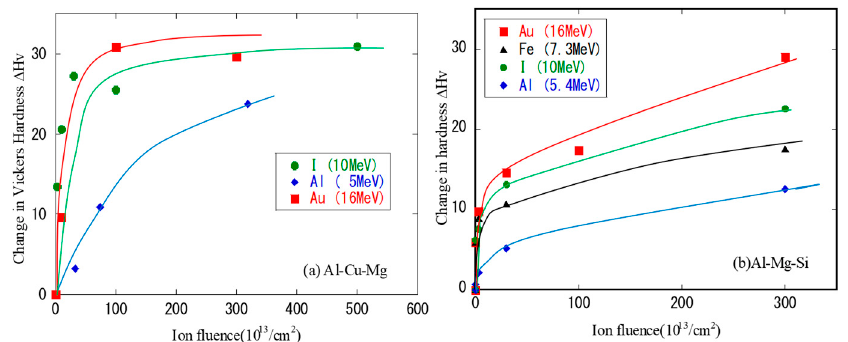
Figure 6. Change in Vickers hardness as a function of ion fluence for ( a ) Al-Cu-Mg alloy and ( b ) Al-Mg-Si alloy. The values of hardness before the irradiation is 120 for Al-Cu-Mg alloy and 67 for Al-Mg-Si alloy.